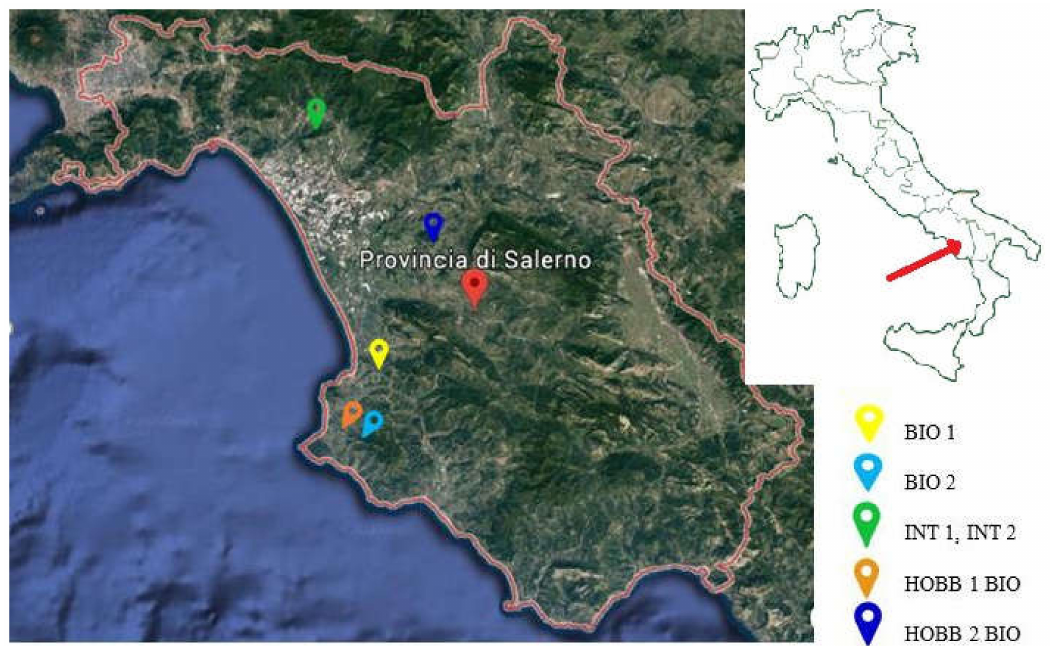
Figure 1. Map of Salerno Province with the location of the analyzed systems.